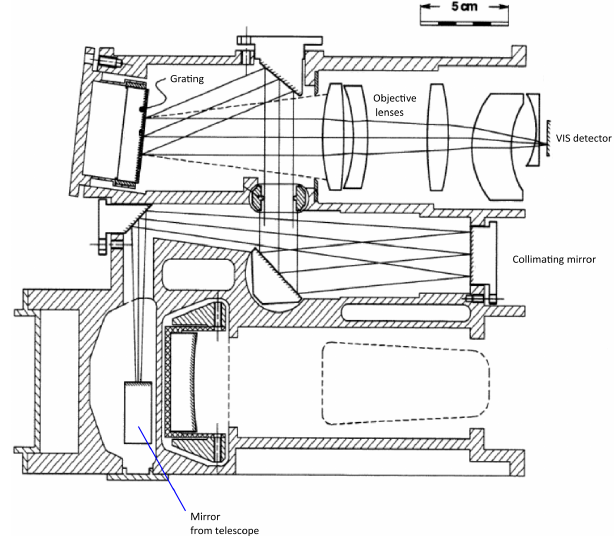
Figure 3. Optical design of the VIS channel. The light coming from the telescope (not shown) enters the VIS channel via the mirror from the